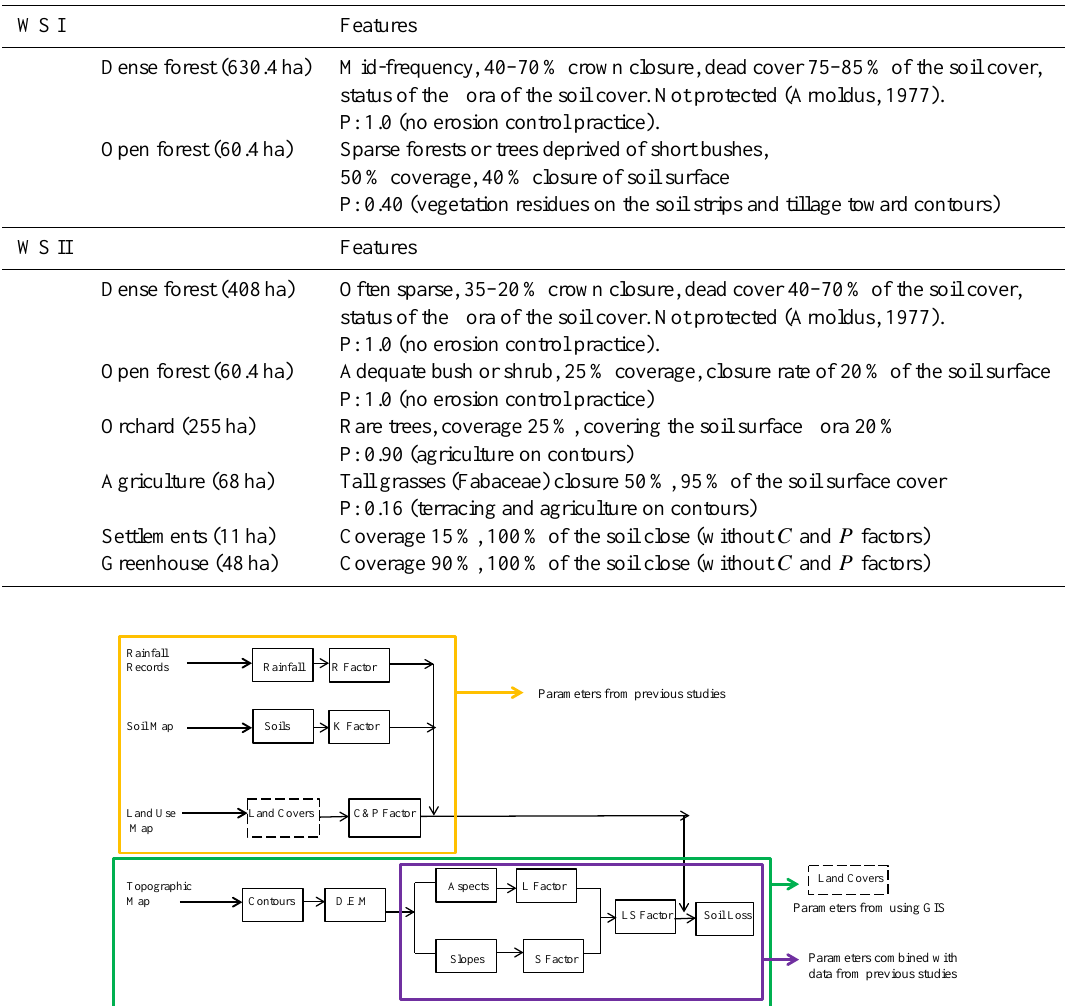
Table 2. Cropping management ( C ) and erosion control practice ( P ) factors for WS I (adapted from Arnoldus (1977) and Balcı (1996).